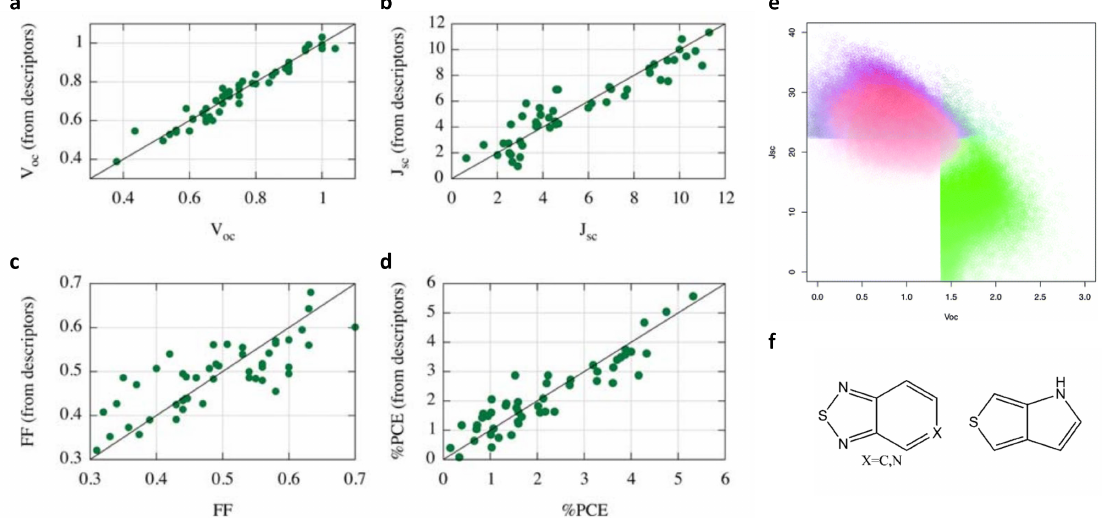
Figure 1. Machine learning (ML)-guided design of organic photovoltaics. ( a – d ) The performance of ML models on desired properties: V oc , J sc , filler factor (FF), and power conversion efficiency (%PCE); ( e ) top 10% screened molecules with highest predicted V oc (green), J sc (blue), and V oc J sc (red); ( f ) the most promising building blocks screened by V oc J sc model. The figures are adapted from Reference [70] with permission from The Royal Society of